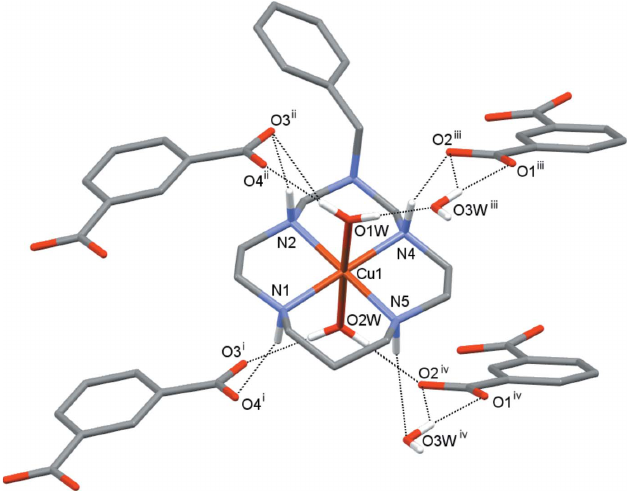
Figure 4 Nearest surrounding of the macrocyclic cation in (II) formed by hydrogen bonding (dashed lines). [Symmetry codes: (i) x + 1, y , z ; (ii) x + 1, (cid:5) y + 1 z +